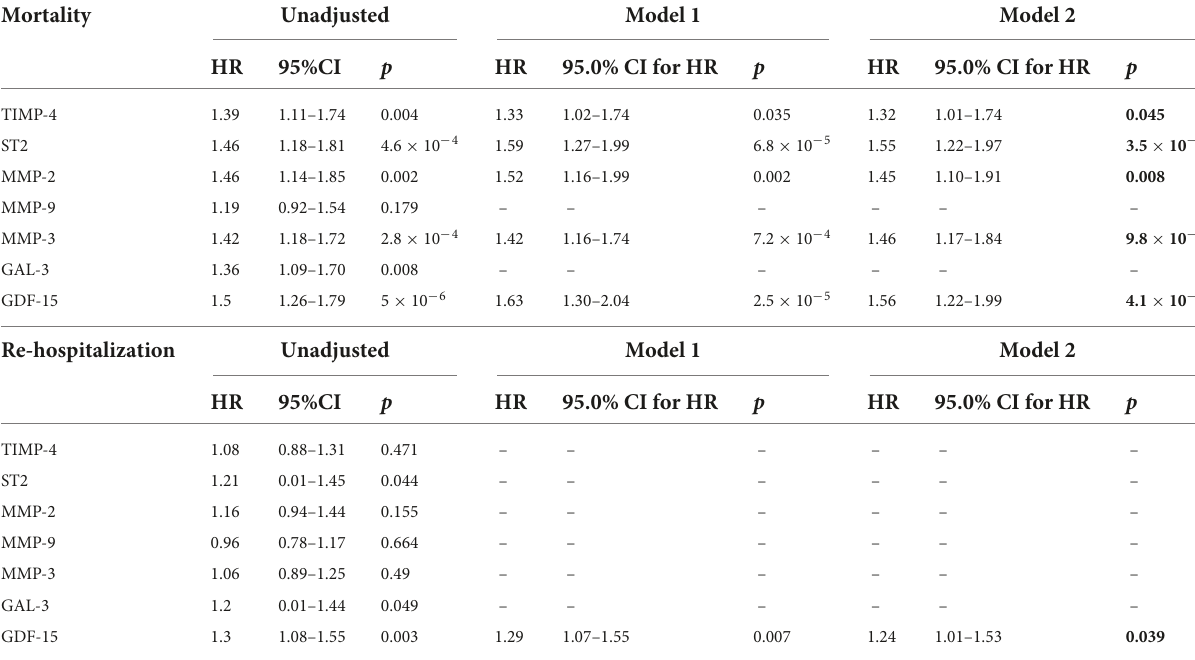
TABLE 4 Cox regression analyses displaying the associations between myocardial fibrosis biomarkers and mortality and re-hospitalization for participants without prevalent AF. Mortality